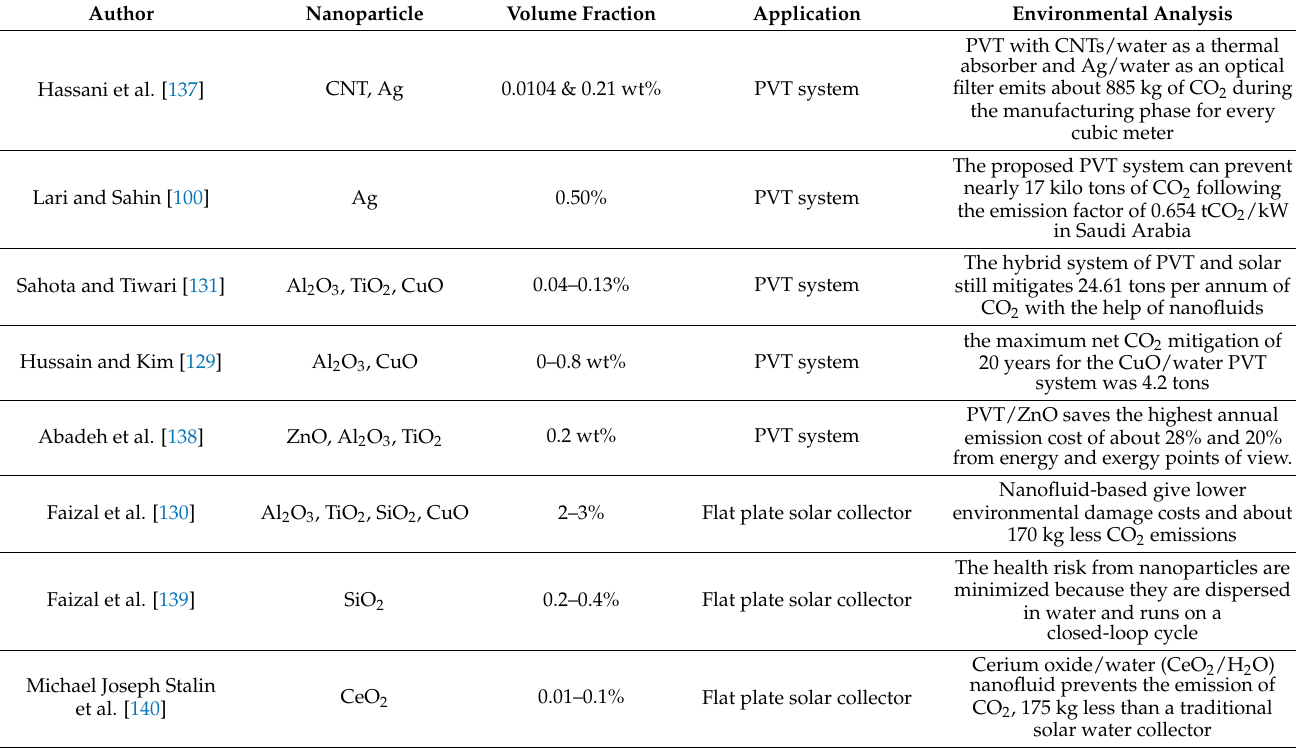
Table 4. Research on the environmental effect of nanofluid utilization in sheet and tube thermal